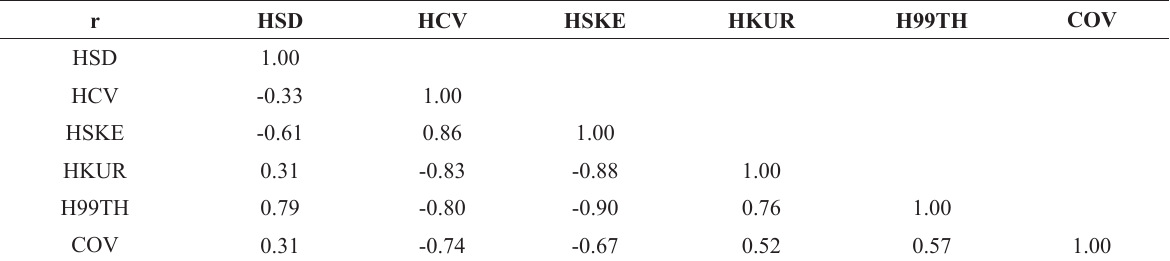
Pearson’s correlation matrix among LiDAR metrics selected.